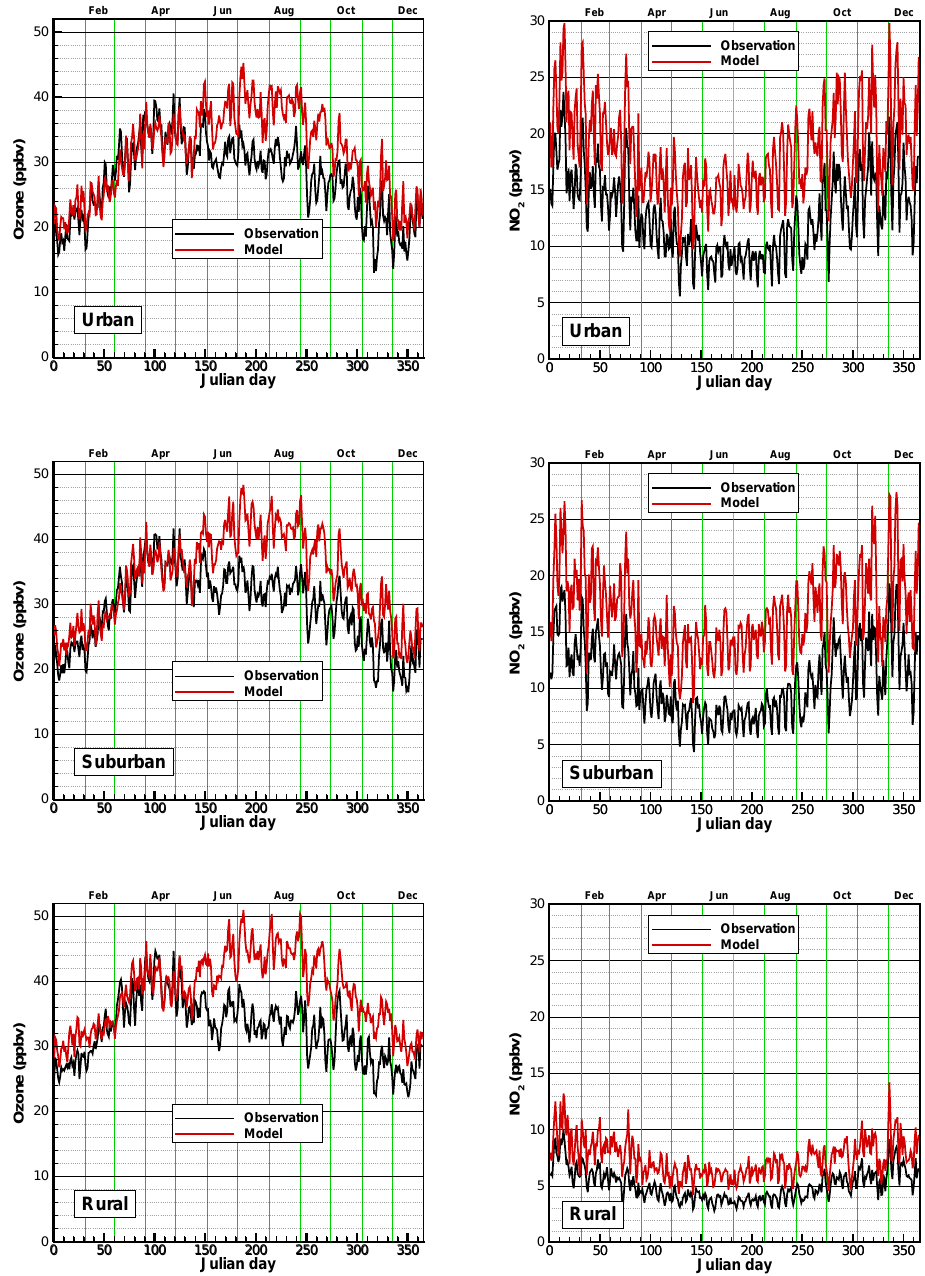
Fig. 5. Daily domain-wide average ozone and NO 2 concentrations at urban, suburban, and rural sites in 2010.